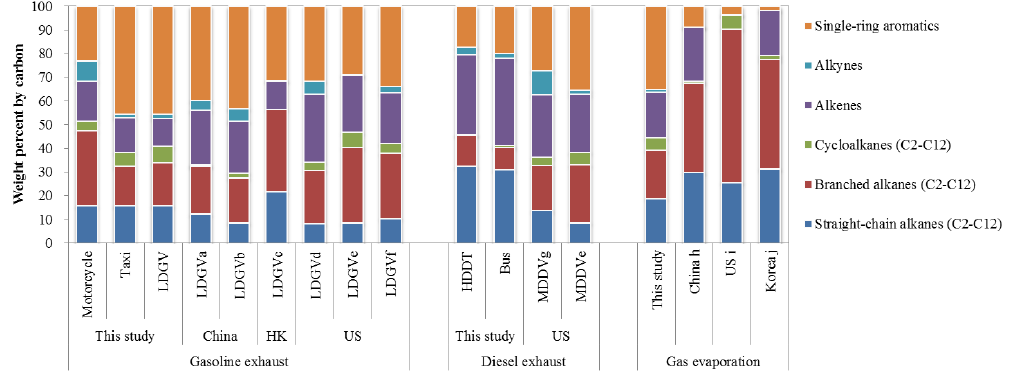
Figure 4. Comparisons of measured VOC compositions of the exhausts from different vehicle types and gas evaporation to the results in other studies (a. Liu et al., 2008; b. Wang et al., 2013; c. Guo et al., 2011; d. Schauer et al., 2002; e. May et al., 2014; f. Gentner et al., 2013; g. Schauer et al., 1999; h. Zhang et al., 2013; i. Harley et al., 2000; j. Na et al., 2004).